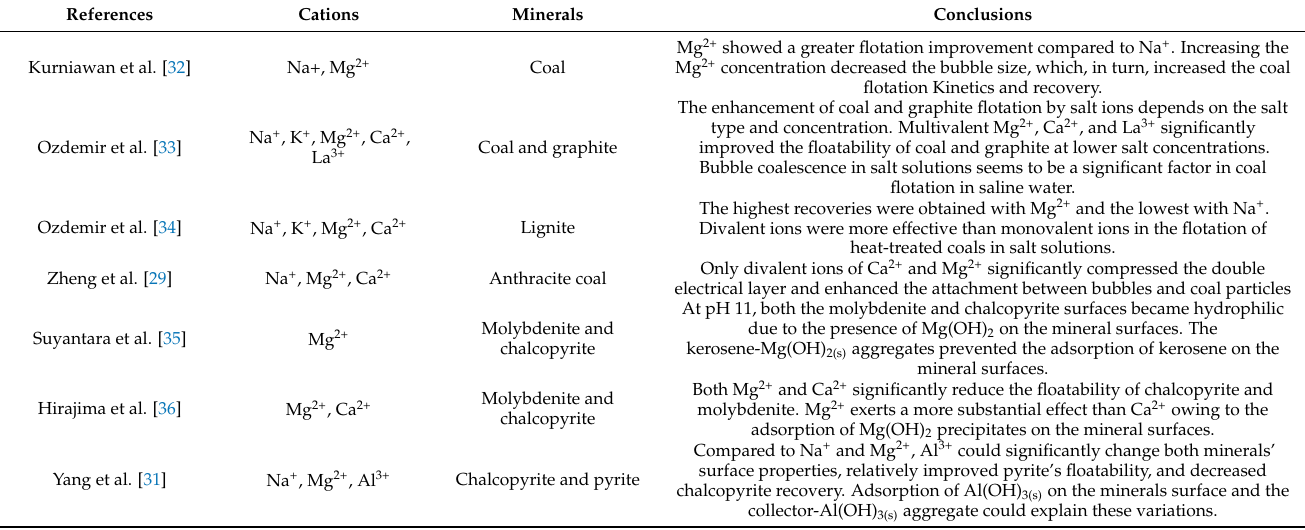
Table 1. The effects of cations on the flotation process of typical hydrophobic minerals